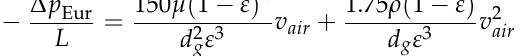
Table 5. ANOVA evaluation of linear, quadratic, and interaction terms for response and coefficient of Δ p model. Source Sum of Squares